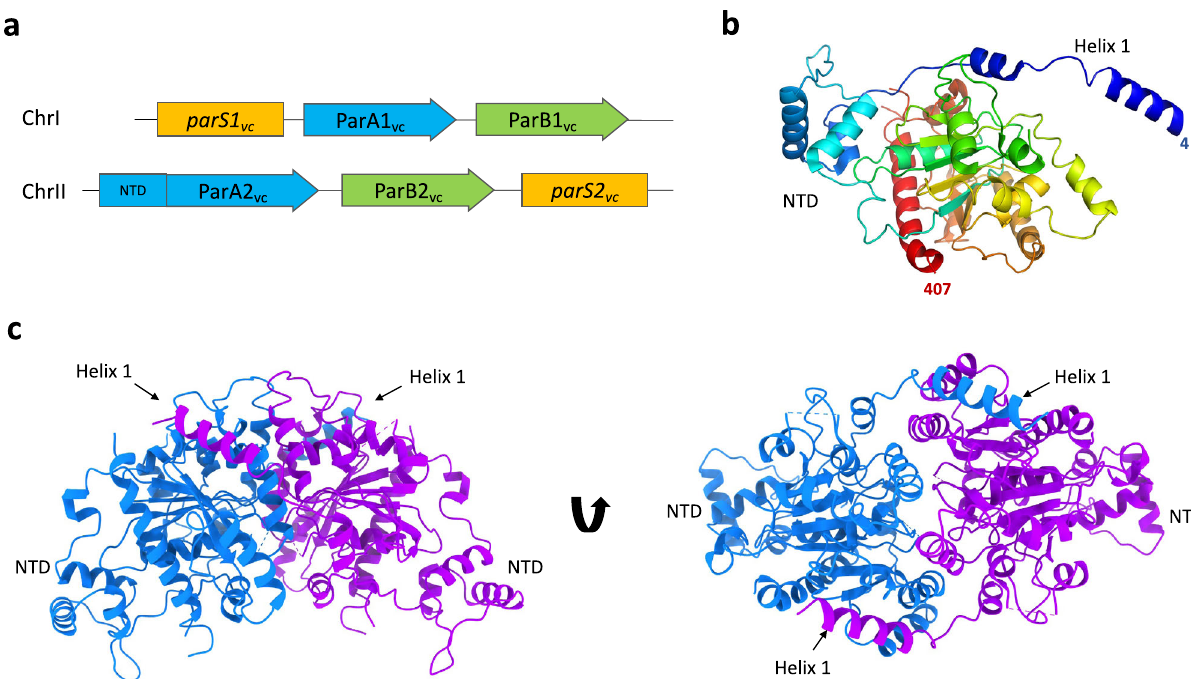
Fig. 1 Structure of the ParA2 vc dimer. a Schematic representation of the chromosome segregation systems for the V. cholerae chromosome 1 (top), and chromosome II (bottom). The centromere-like partition site is in yellow (parS ), the adapter parS binding protein is in green (ParB) and the NTPase protein is in blue (ParA), with the additional N-terminal domain (NTD) found only in ChrII shown. b Cartoon representation of the ParA2 vc crystal structure, in rainbow coloring, starting from blue at the N terminus, to red at the C terminus. c The crystallographic dimer of ParA2 vc shown from the side (left) and top (right), with the two symmetry-related pairs in blue and magenta, respectively. The NTD and helix 1 are indicated.